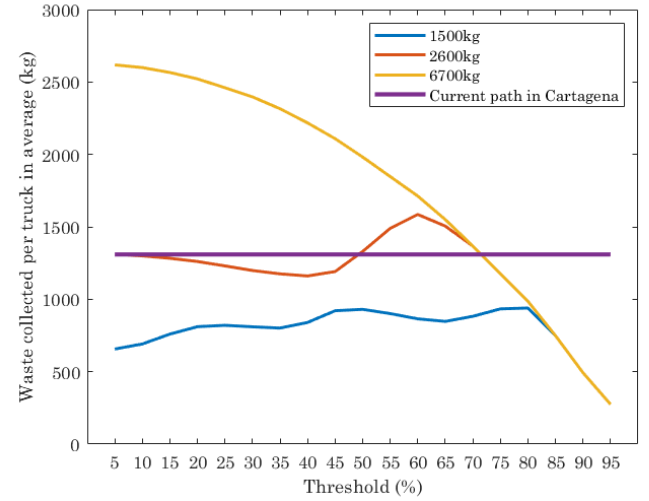
Figure 4. Average waste collected per truck (different truck capacity) for the optimal path given by ILP and the real behavior of truck routes in Cartagena.